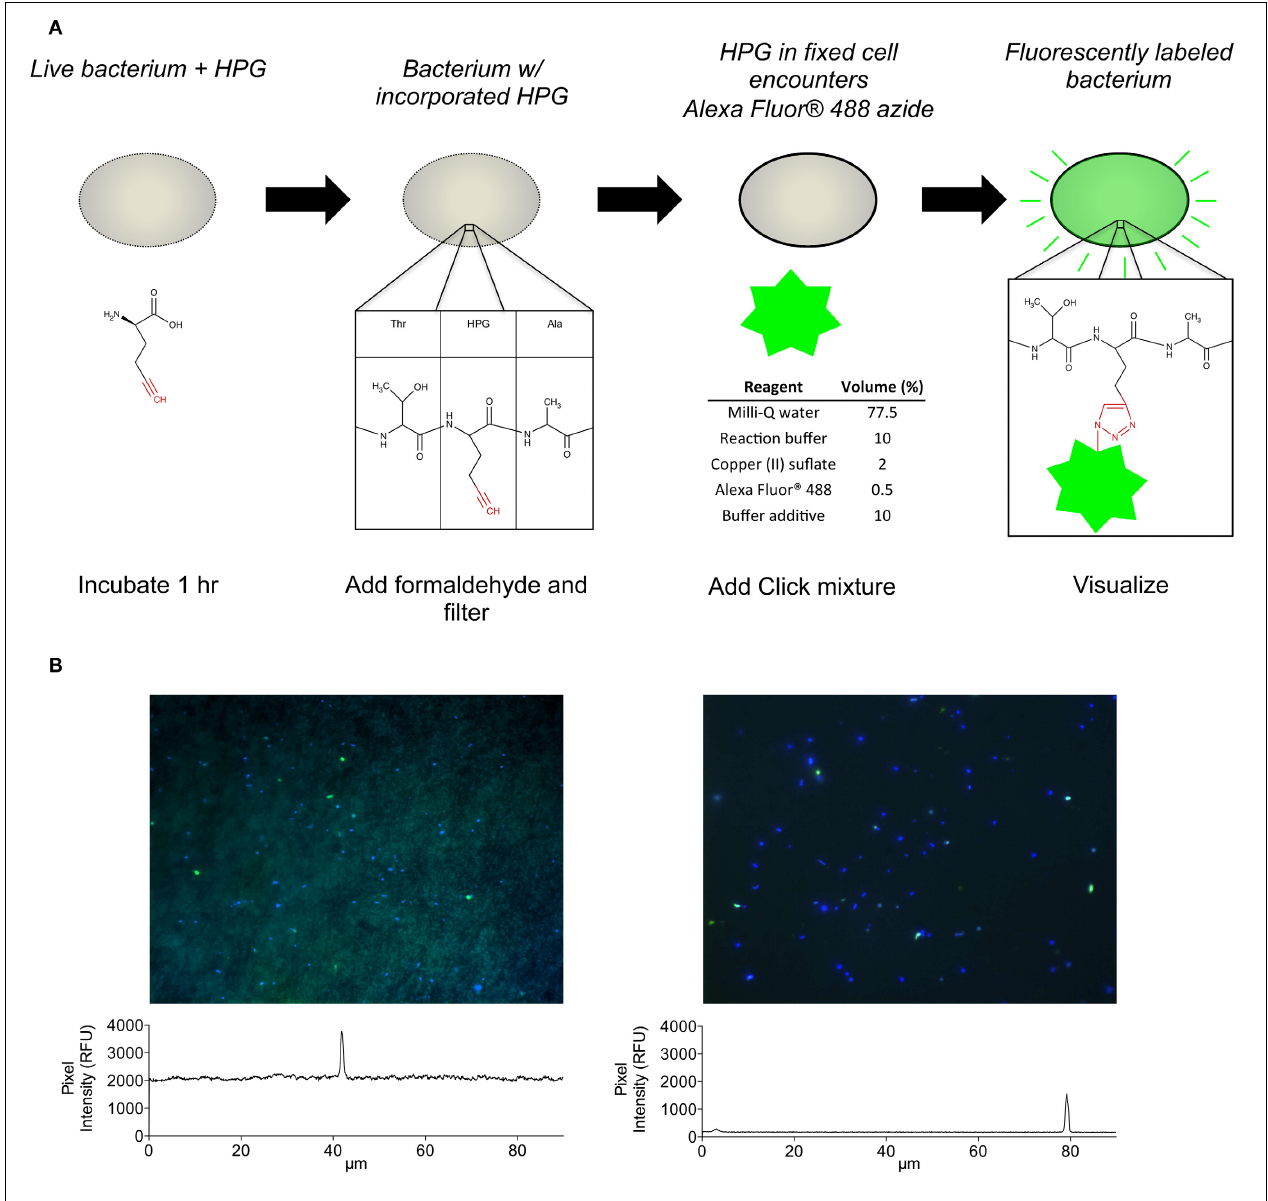
FIGURE 1 | (A) Conceptual flow chart summarizing the HPG incorporation and detection method. (B) A representative view of HPG-labeled bacteria (green cells) among all bacteria (blue cells) observed on polycarbonate filters (left) and coverslips after